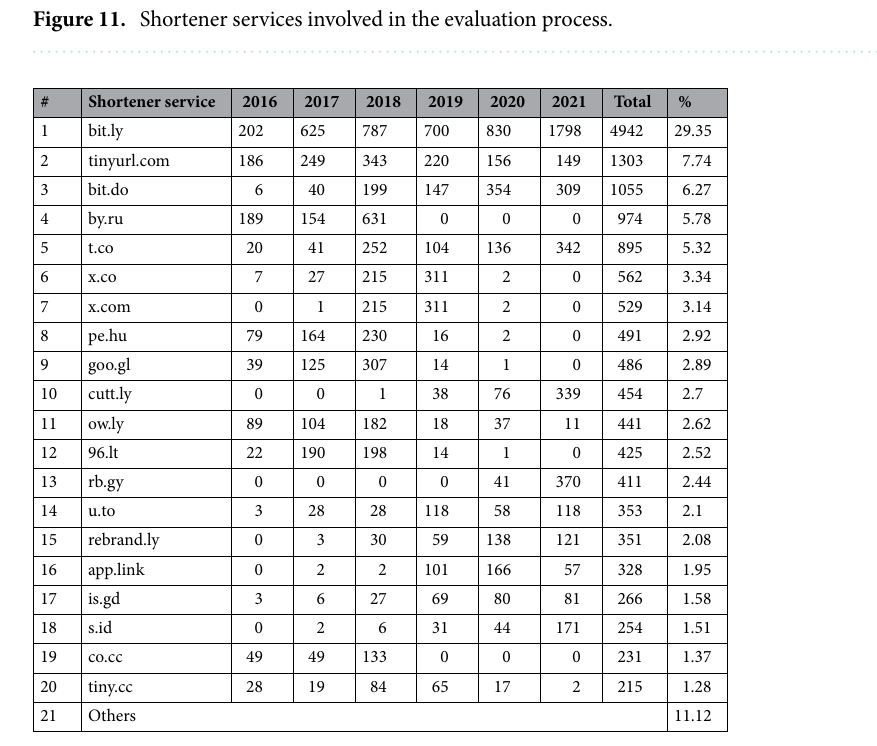
Table 5. Top 20 shortener services involved in the evaluation